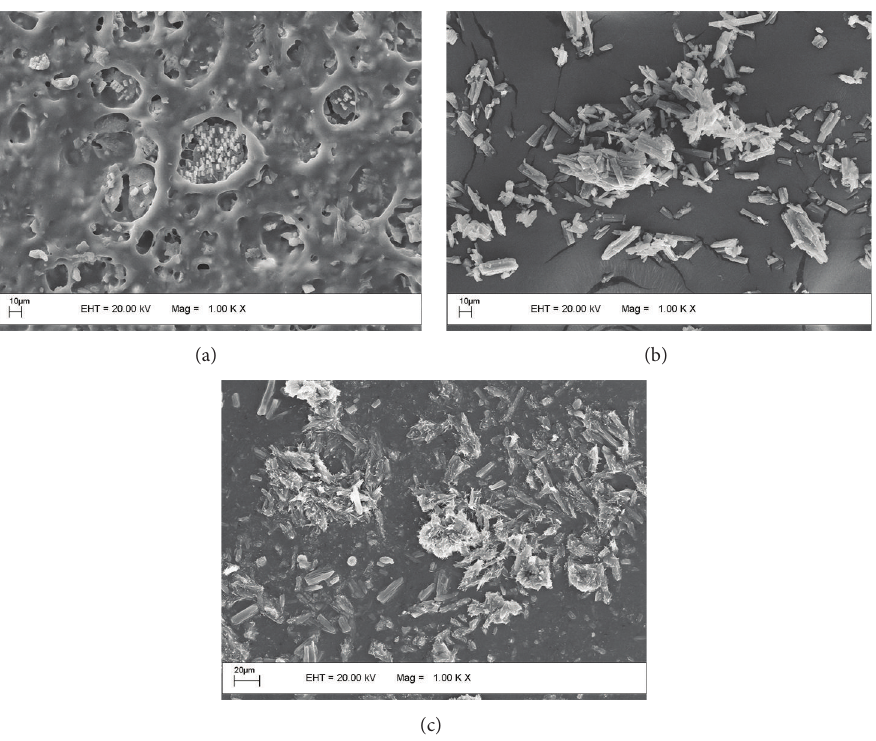
Figure 3: SEM-EDS spectra of (a) NRL membrane, (b) ciprofloxacin powder, and (c) NRL membrane + ciprofloxacin. Note that the drug is present in the NRL matrix.